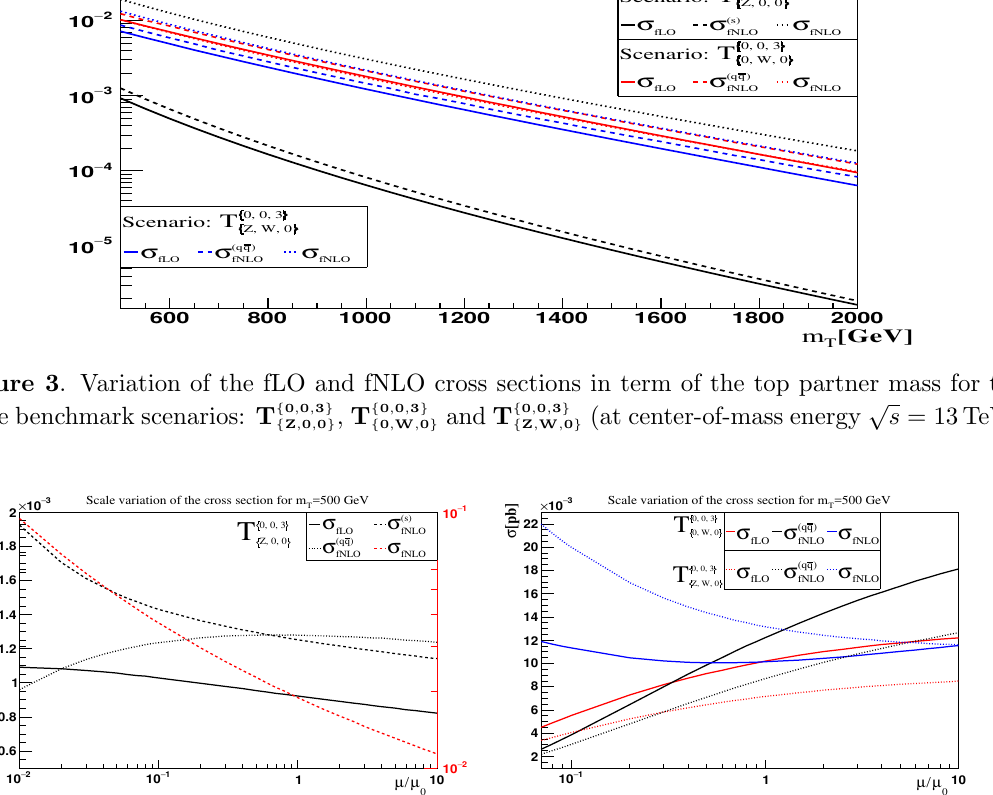
, T f 0 ; 0 ; 3 g f Z ; 0 ; 0 g f 0 ; W ; 0 g